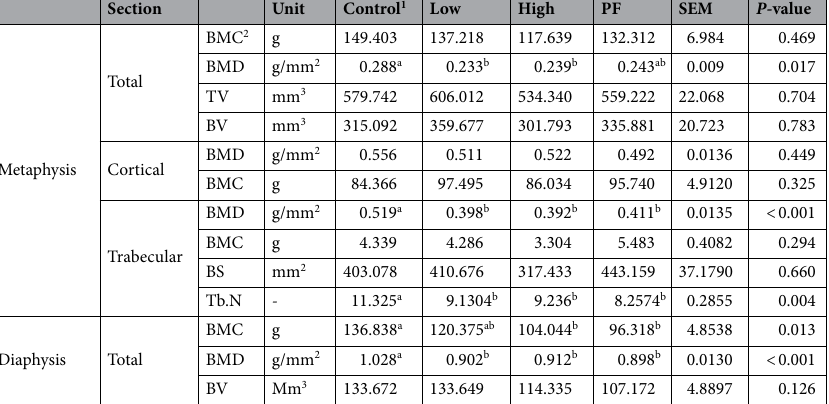
Table 2. Femur bone metaphysis and diaphysis structure in broiler chickens at 6 dpi. 1 Control: uninfected controls fed diet ad libitum and gavaged with water; Low: low Eimeria- infected group fed diet ad libitum and gavaged with 50,000 oocysts of E. maxima , 50,000 oocysts of E. tenella , and 250,000 oocysts of E. acervulina ; High: severely Eimeria -infected group fed diet ad libitum diet and gavaged with 12,500 oocysts of E. maxima ; 12,500 oocysts of E. tenella ; 62,500 oocysts of E. acervulina ; PF: an uninfected pair-fed group that fed the same amount of feed as the High group, gavaged with water. 2 BMC, bone mineral content; BMD, bone mineral density; TV, total bone volume; BV, bone volume (TV minus bone marrow volume); BS, bone surface area; Tb. N, trabecular number. a,ab,b Treatments with different letters means a significantly difference between treatments by using Tukey’s HSD test, P < 0.05, N =